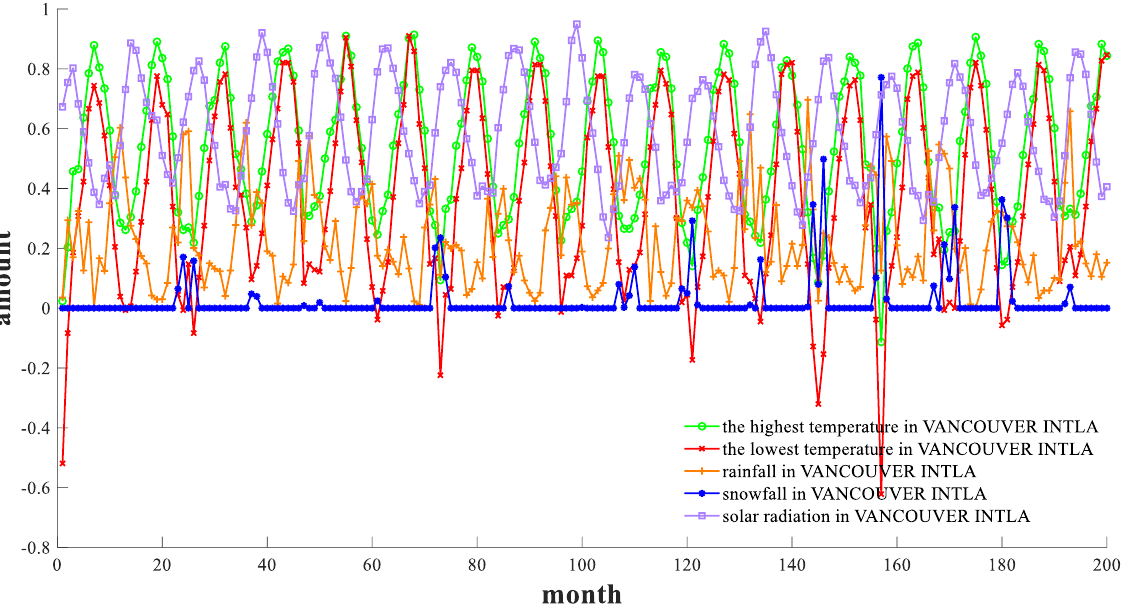
Figure 2. Process of the proposed SOPDEL model.